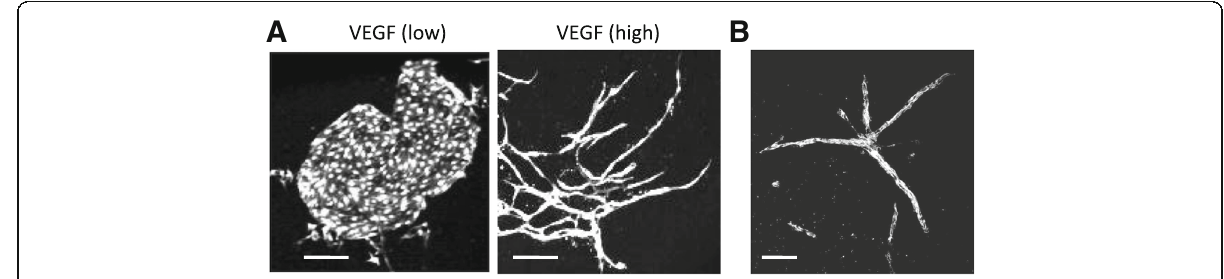
Fig. 3 Elongation of endothelial cells derived from ES cells. a In the co-culture system with OP9 stromal feeder cells, ES-derived endothelial cells form a round colony in the presence of a low level of VEGF, which produced by OP9 cells (left panel). These cells form long elongated structures, when stimulated by a high level of VEGF (right panel). Scale bar 200 μ m. b ES-derived endothelial cells form vessel-like structures in the 3D collagen gel culture. Scale bar 100 μ